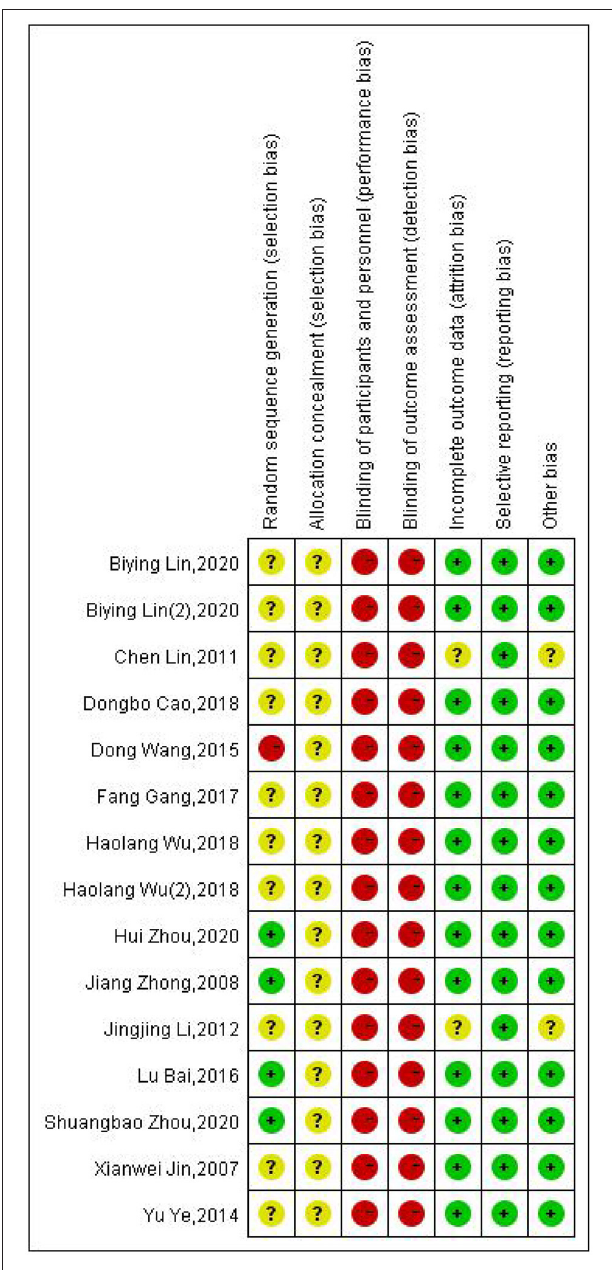
adverse reactions were reported in one report (30). Four